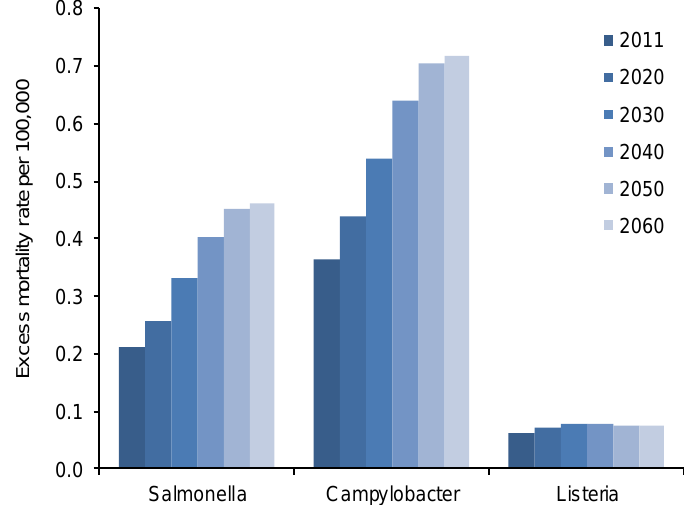
Figure 3. Estimated excess mortality over all ages per 100,000 population due to disease from three foodborne pathogens until 2060. The changes depicted are based on changes in population buildup regarding age as independent